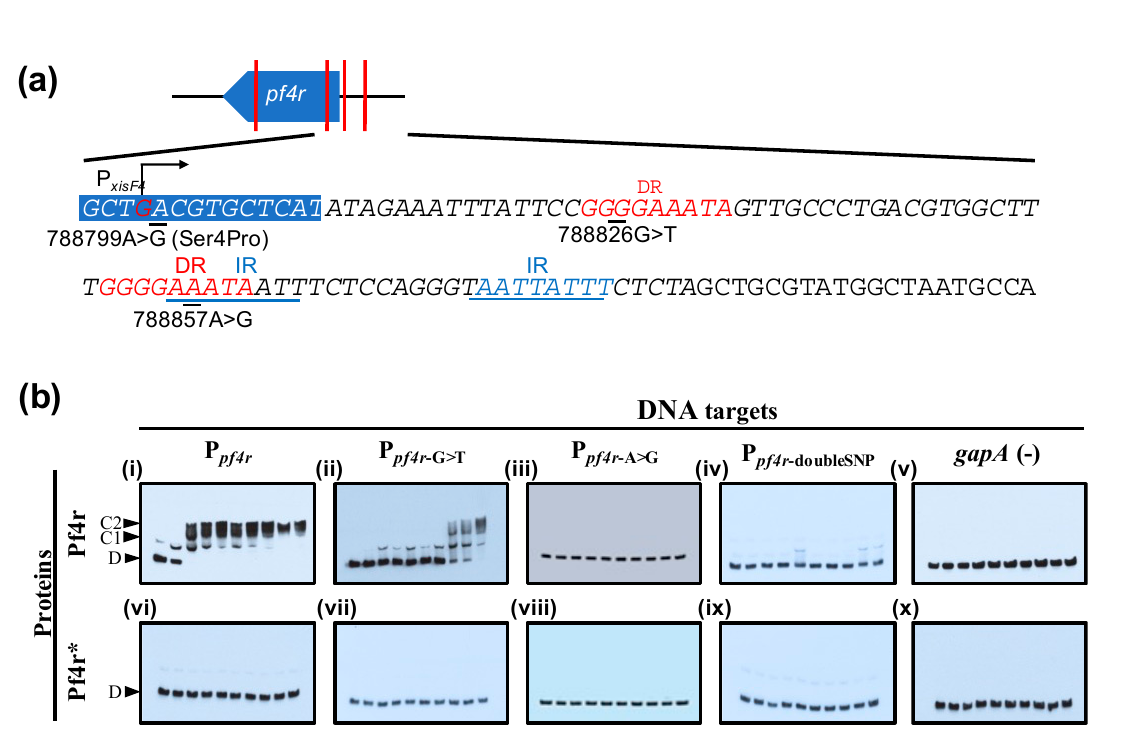
Figure 5. EMSA of Pf4r and Pf4r* protein gradients on target DNA. ( a ) The positions of pf4r relative to the Pf4 genes and the single nucleotide polymorphisms within the pf4r region relative to the PAO1 genome are indicated (red vertical lines). Italicised nucleotide sequences are part of the probe used in the EMSA. The locations of the direct repeats (DR), inverted repeats (IR) and promoter start sites were as seen in Li et al. [21] . ( b ) P pf4r indicates the wild-type promoter region. The P pf4r -A>G , P pf4r -G>T and P pf4r -doubleSNP probes have mutations in either 788857A>G or 788826G>T, or both positions, respectively. The binding of Pf4r and Pf4r* to the selected target regions was tested using an increasing protein gradient (lanes 1-10 were 0, 10, 20, 30, 40, 50, 60, 70, 80 and 90 nM, respectively). The non-target gapA (100 bp) gene was randomly chosen as the negative control for the assays. The notations indicate free DNA (D), protein–DNA complex (C1) and protein dimer–DNA complex (C2). Pf4r restores LasB activity to the Pf4 knockout and increases frequency of variants.